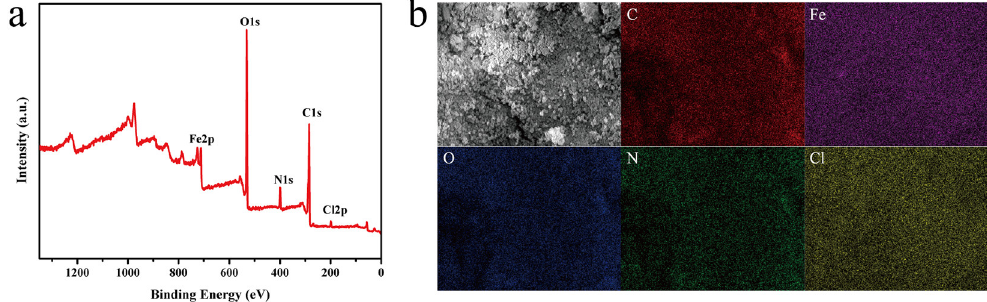
Figure 4. XPS spectra of NH 2 -Fe-MIL-101 ( a ), SEM images of NH 2 -Fe-MIL-101 and the corresponding EDS-elemental mapping of C, Fe, O, N and Cl ( b ).